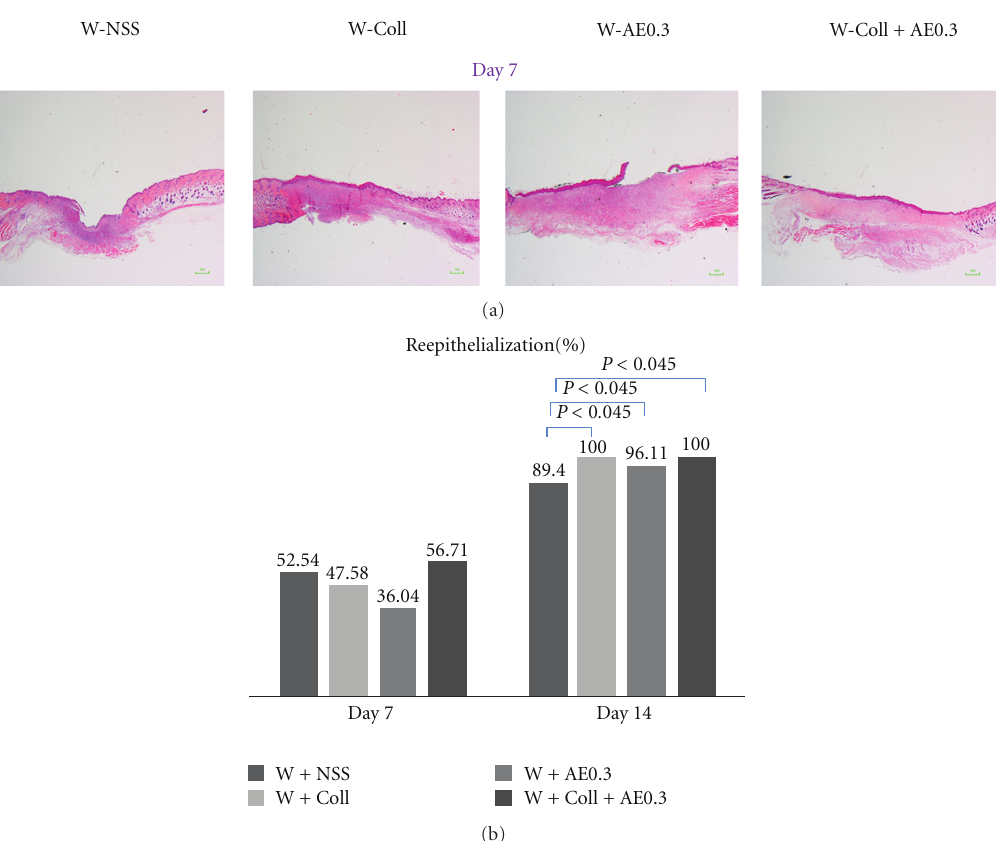
Figure 6: (a) Reepithelialization on day 7. (b) Means ± SEM of wound area of the W-NSS, W-AE, W-Coll, and W-Coll-AE groups (d) on days 7 and